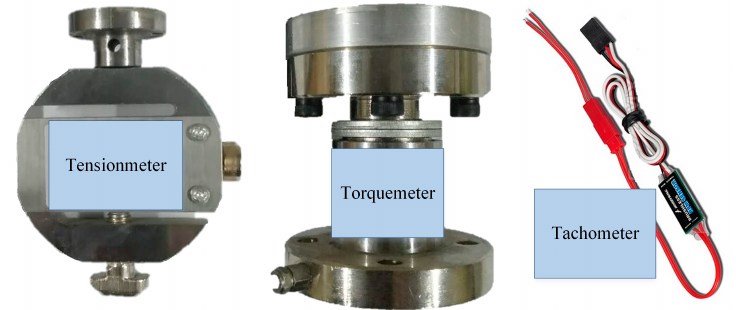
Figure 4. Tensionmeter, torquemeter and tachometer.